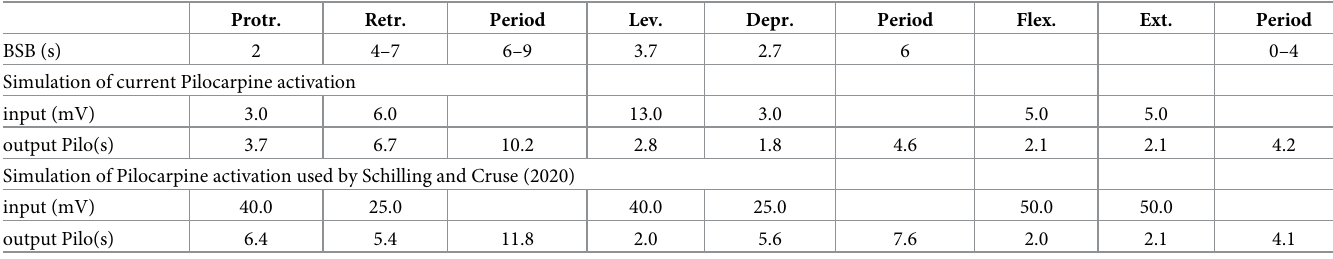
Table 2. Setting of input parameter and the corresponding periods for the fourth experiment (pilocarpine application).